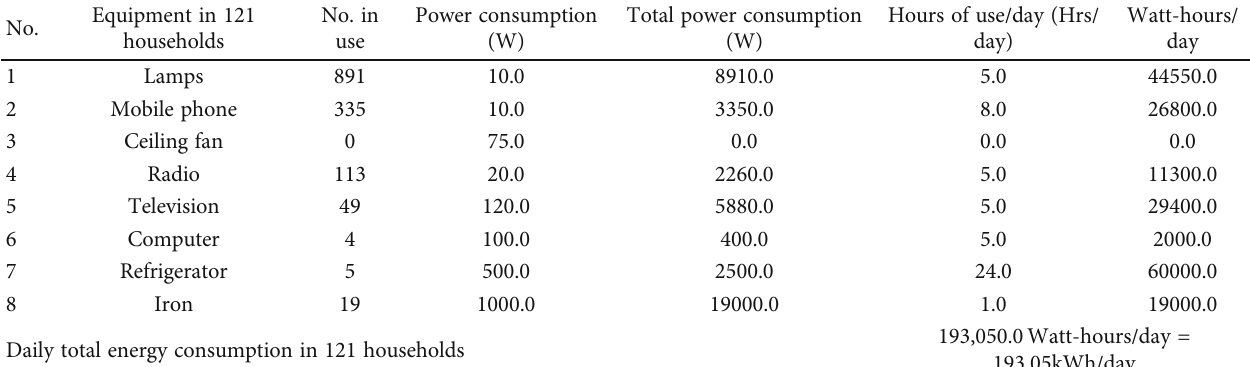
Table 2: The projected everyday electricity demand for 121 houses in the